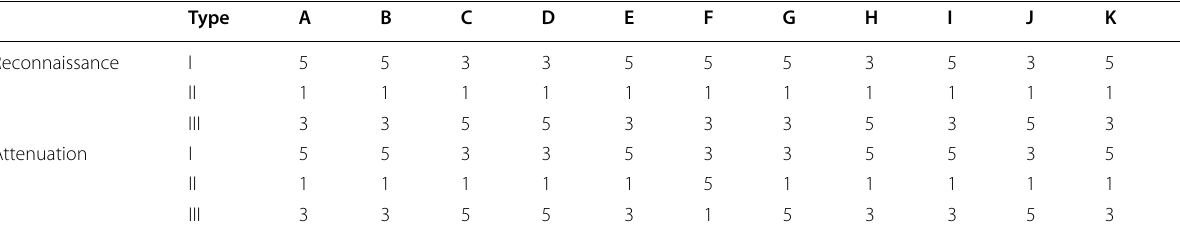
Table 10 Scores of the types that were easy to use in a ranked order